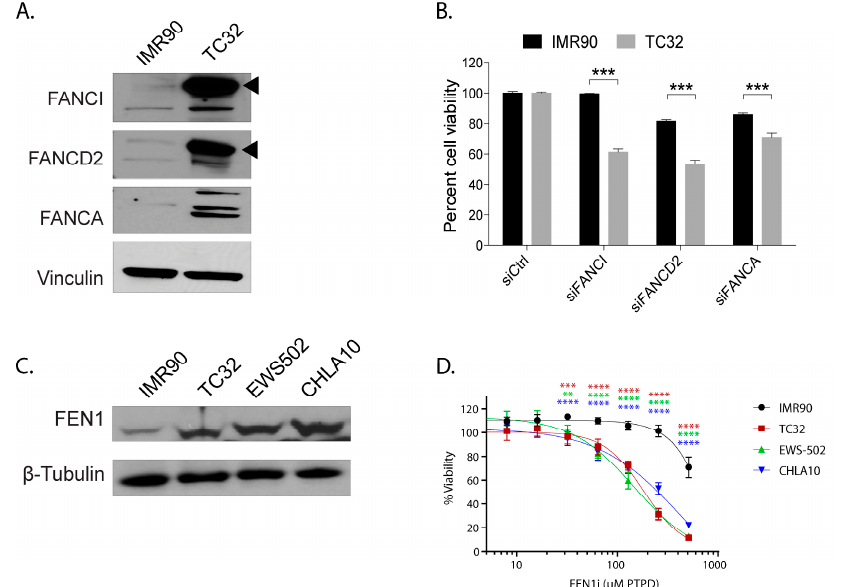
Figure 7. The response to replication stress is a defining feature for Ewing sarcoma compared to the PHATE_1-high developmental context. ( A ) Western blot showing expression of Fanconi Anemia proteins FANCA, FANCD2, and FANCI in TC32 (Ewing sarcoma cell line) compared to IMR90 (fibroblast cell line); ( B ) Bar-plot showing the impact of FANC genes knockdown on cell viability in TC32 compared to IMR90; ( C ) Western blot showing the expression of FEN1 in Ewing sarcoma cell lines TC32, EWS502, and CHLA10 compared to IMR90; ( D ) Line plot showing the viability of Ewing sarcoma cells compared to IMR90 with increasing doses of FEN1 inhibitor. (** p ≤ 0.01; *** p ≤ 0.001; **** p ≤ 0.0001).